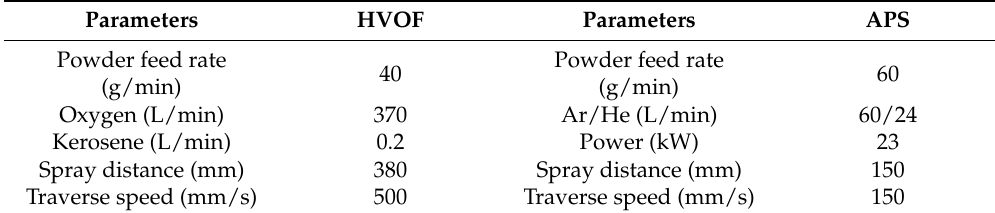
Table 1. Optimized spraying parameters of both high entropy alloy (HEA)